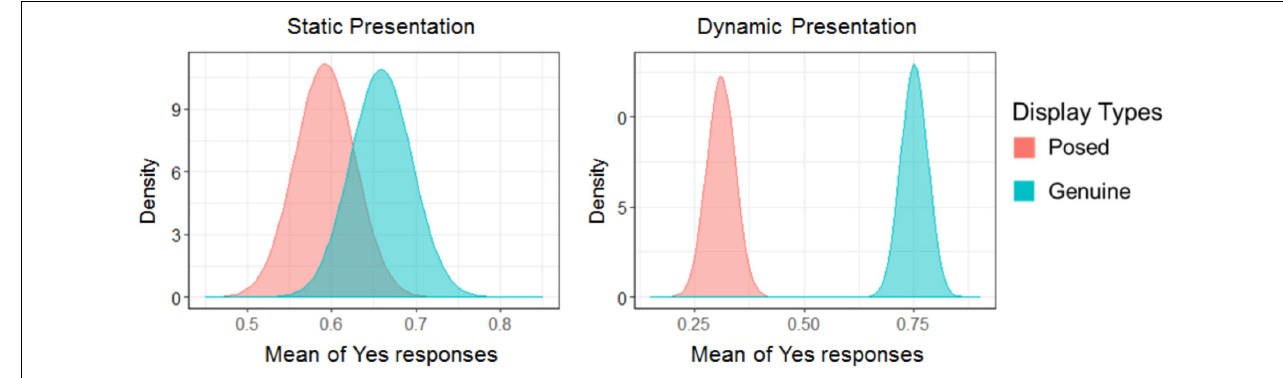
FIGURE 3 | The mean of Yes responses in the feel condition for all emotions. The distance between the two distributions can be interpreted as the discriminability of facial displays.